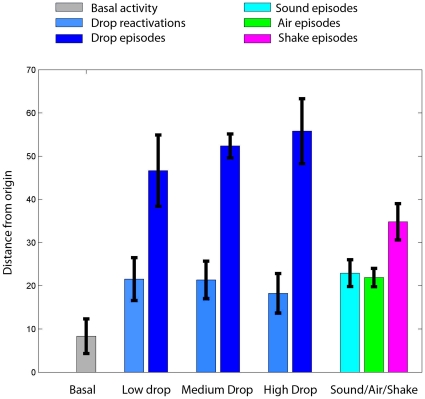
Similar magnitudes of reactivated trajectory distances among drop
ensemble traces following low, medium, and high drop.The MDA distances were used as a way for averaging the mean of
reactivated trajectories. The distances from sound, air puff, and shake
clusters to the rest cluster center were also listed on the right side
of the plot.